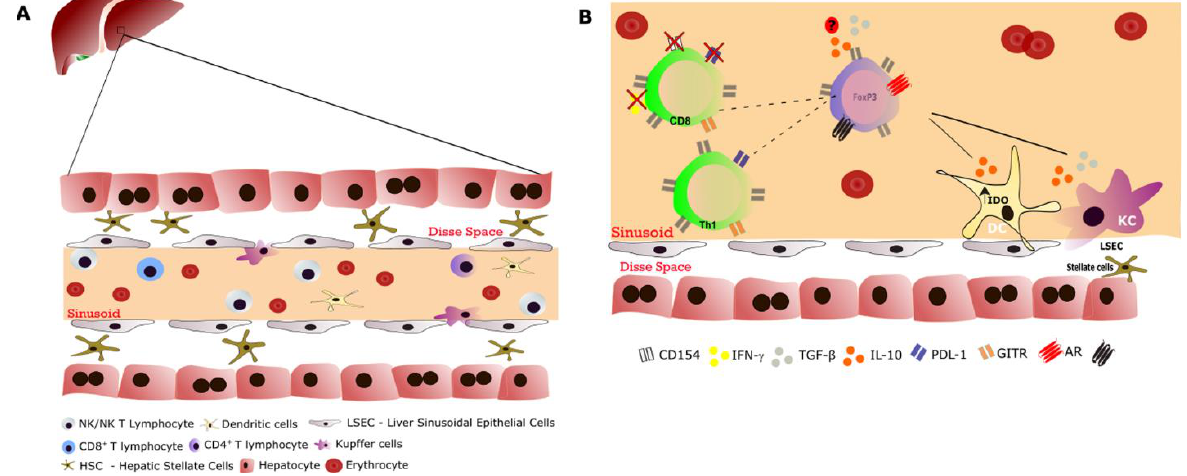
Figure 2. Liver cells in immunity: hepatic cells in homeostasis and the regulatory microenvironment in the immunosuppressive response after LT. ( A ) The liver is an organ composed of parenchymal (hepatocyte) and nonparenchymal cells that exert different functions. During homeostasis, non- parenchymal cells such as Kupffer cells, dendritic cells, NK cells, NKT cells, and HSCs constitute the immunological liver microenvironment, responding to most gut-derived antigens. In addition to these resident cells, there are transient lymphocytes in the sinusoidal space. In addition, hepatocytes can play an immunological role in the context of innate protein release. ( B ) Regulatory T (Treg) cells play an important role in the mechanisms of allogeneic response suppression after LT. Kupffer cells (KCs) and dendritic cells (DCs) have important roles in this regulatory microenvironment mediated through IL-10 production and TGF- β release. These molecules contribute to the induction of Treg cells, which probably act directly to decrease the response via effects on CD4 + (Th1 cells) and CD8 + T cells, minimizing the rejection process. In CD8 + T cells, there is a decrease in CD154, an important protein expressed on the surface of activated cells in humans. Furthermore, in a mouse model, it was observed that cytotoxic T-lymphocyte-associated antigen 4 (CTLA-4) induction in Treg cells promoted an increase in glucocorticoid-induced TNFR-related protein (GITR) on CD8 + and CD4 + T cells, decreasing the rejection responses of these T cells through the induction of apoptosis in these cells, mainly via increased expression of programmed death-ligand1 (PDL-1). Thus, the production of inflammatory cytokines, such as IFN- γ, was decreased. LSEC: liver sinusoidal endothelial cells; IDO: indoleamine 2,3-dioxygenase.